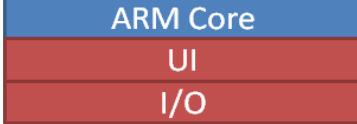
Figure 13. The software architecture of the main system on the ARM-core.